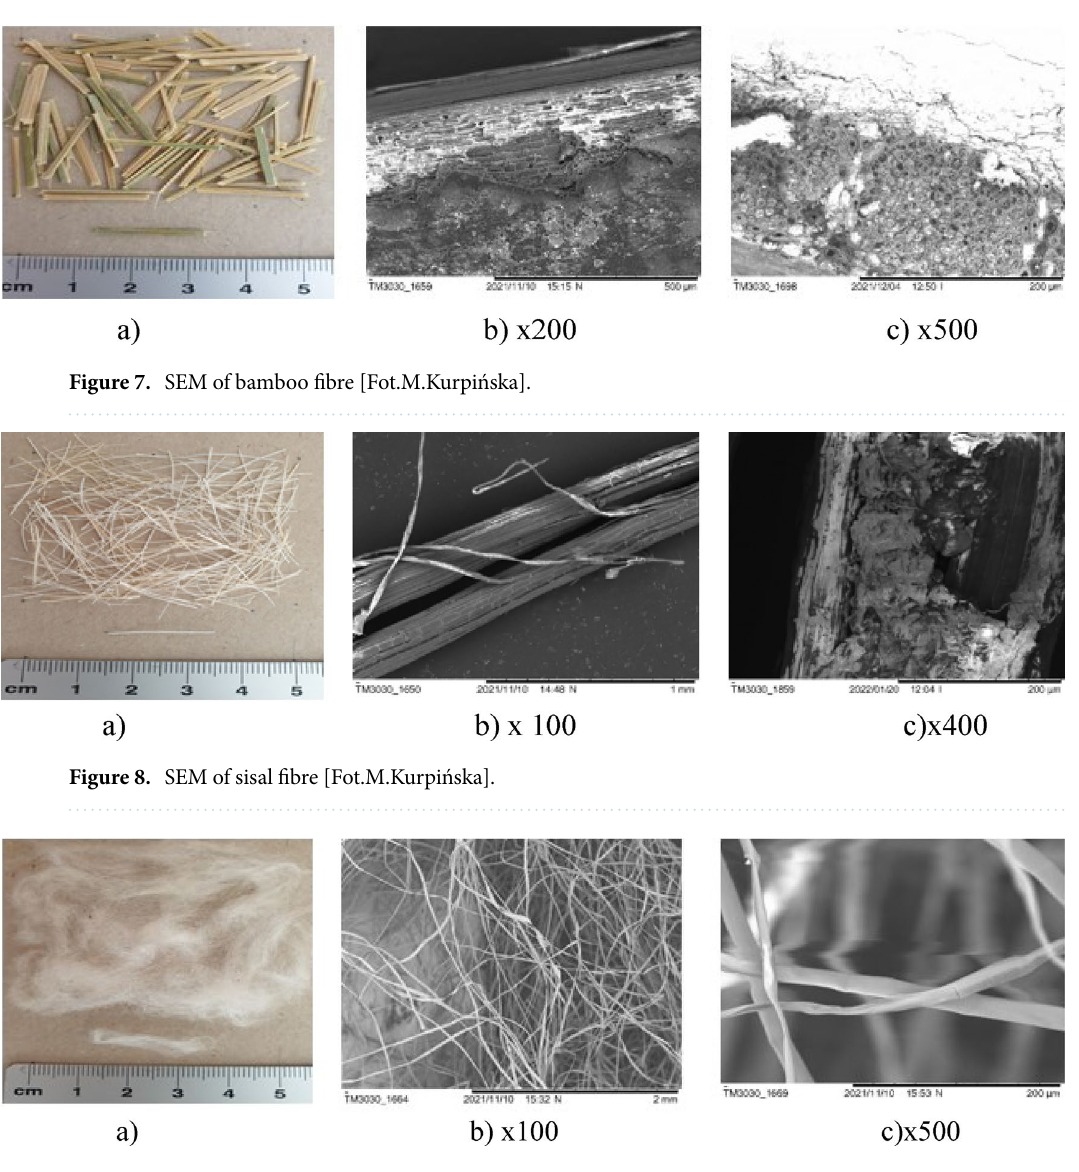
Figure 9. SEM of cotton fibre [Fot.M.Kurpińska].